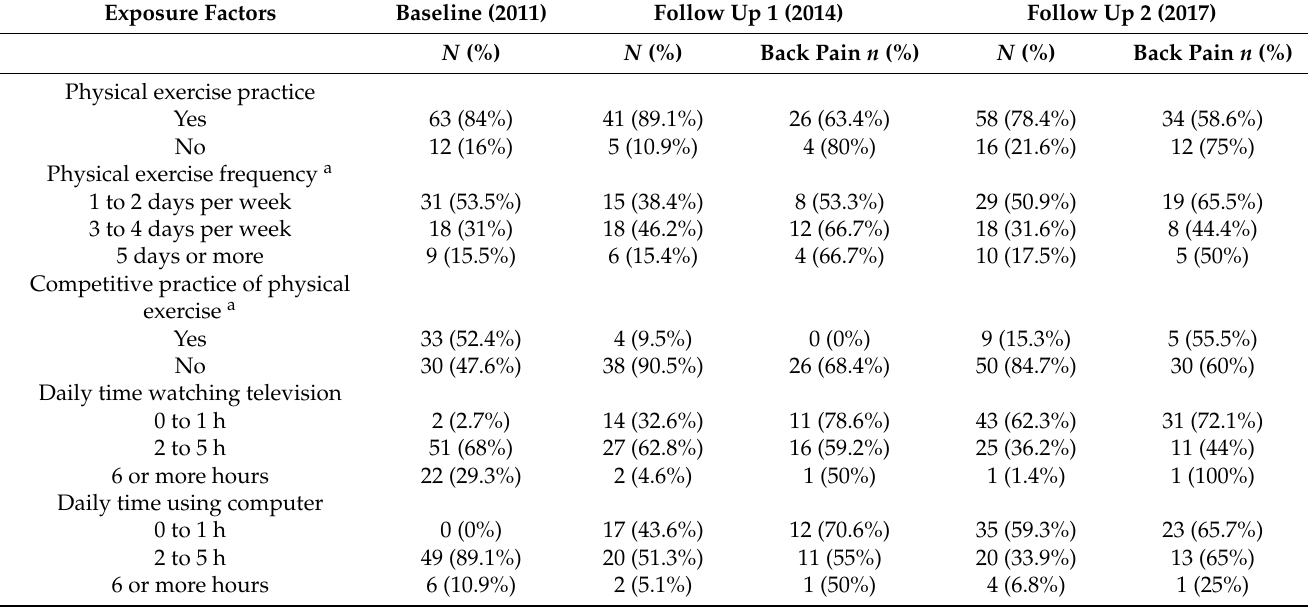
Table 2. Exposure factors frequency (physical exercise, behavioral, postural, and hereditary habits) and back pain frequency